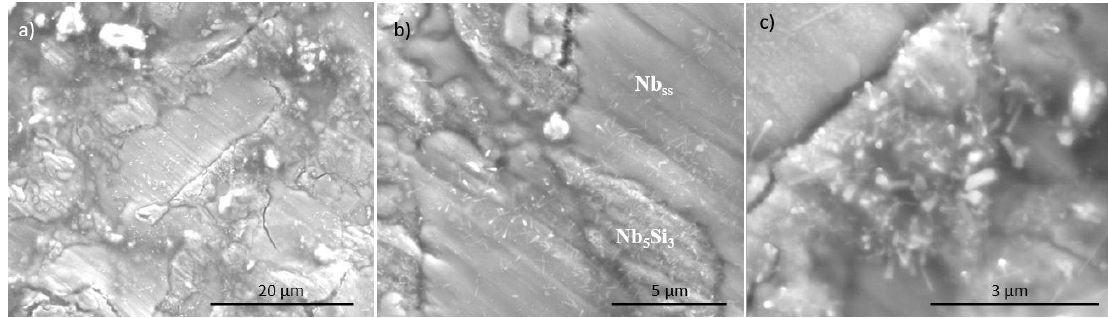
Figure 3. BSE images of scale on the surfaces of the alloy JN1 after isothermal oxidation at 800 °C, ( a ) showing overview of surface and ( b ) and ( c ) showing detail. The phases below the scale are indicated in ( b ).